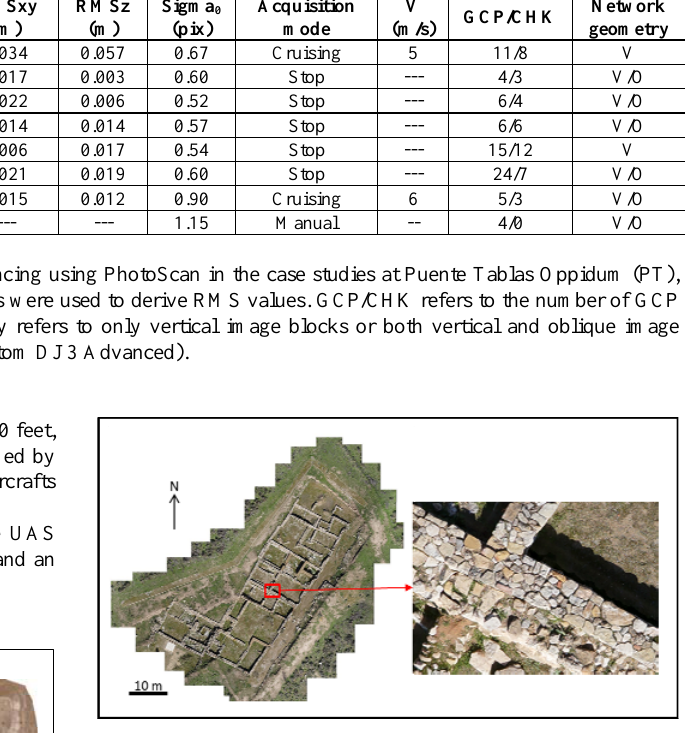
Figure 10. Orthoimage (1 cm resolution) of the Village (V) sector in Puente Tablas Oppidum.